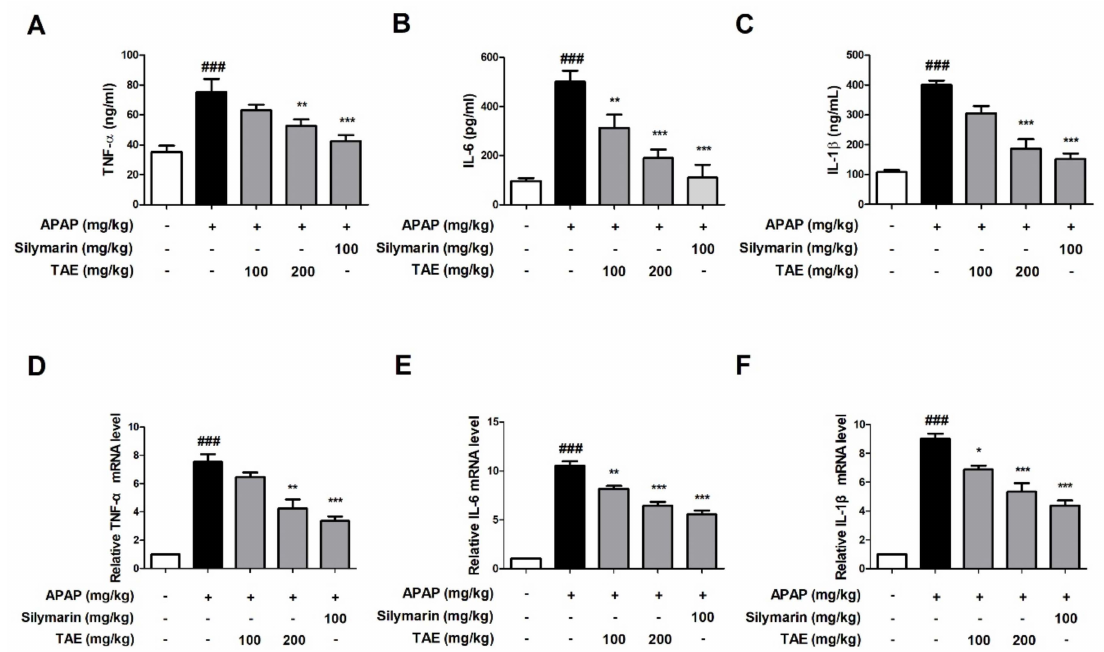
Figure 4. Effect of ethanolic Triticum aestivum sprout extract on inflammatory cytokine production in mice with N -acetyl- para-aminophenol (APAP)-induced hepatotoxicity. Inflammatory cytokine levels were confirmed by ELISA and qRT-PCR. ( A ) TNF- α expression. ( B ) IL-6 expression. ( C ) IL-1 β expression. ( D ) TNF- α mRNA expression. ( E ) IL-6 mRNA expression. ( F ) IL-1 β mRNA expression. All data are shown as mean ± SD. ### p < 0.001 versus Normal group; * p < 0.05, ** p < 0.01, and *** p < 0.001 versus APAP group. APAP, N -acetyl-para-aminophenol (acetaminophen); GAPDH, glyceraldehyde 3 phosphate dehydrogenase; IL, interleukin; TNF- α , tumor necrosis factor-alpha; qPCR: Quantitative polymerase chain reaction; TAE, Triticum aestivum sprouts